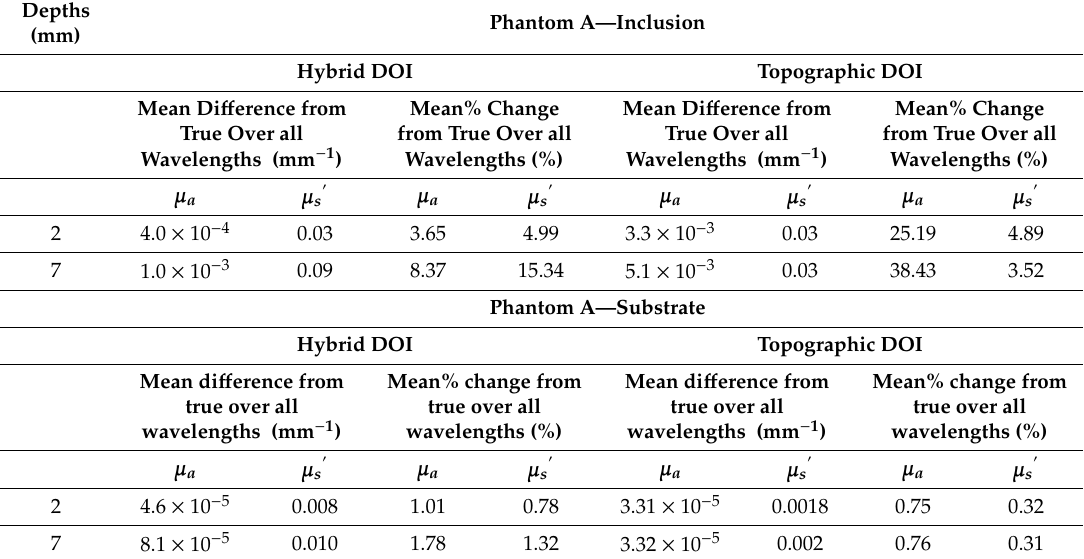
Table 4. Mean di ff erence and mean percentage change of recovered ( µ a , µ s (cid:48) ) from true ( µ a , µ s (cid:48) ) over all wavelengths for phantom A.